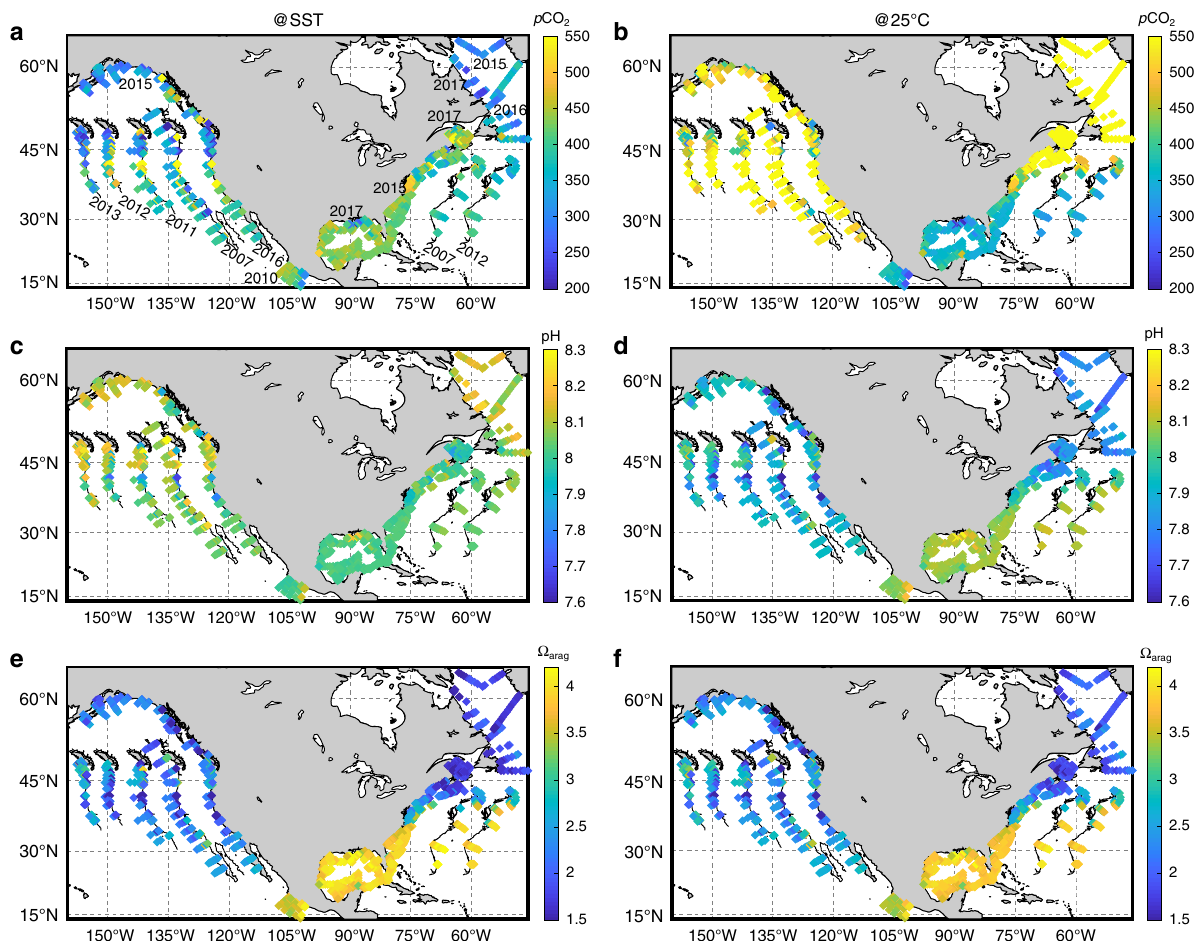
Fig. 3 Distributions of marine carbonate system parameters. Shown are parameters in surface seawater along the North American margins at fi eld temperature and normalized to 25 °C. Left column panels are at fi eld temperature (@SST), while the right column panels are at 25 °C. a , b Partial pressure of CO 2 ( p CO 2 ), c , d pH (on the total scale), and e , f aragonite saturation state ( Ω arag ). Note that the temperature normalization from fi eld SST to 25 °C is performed under the assumption of a closed system with no gas exchange between surface seawater and the atmosphere (thus no DIC change). As in Fig. 2, only the most recent data are presented in their exact geographic locations, while earlier data are plotted at the correct latitude with a longitude